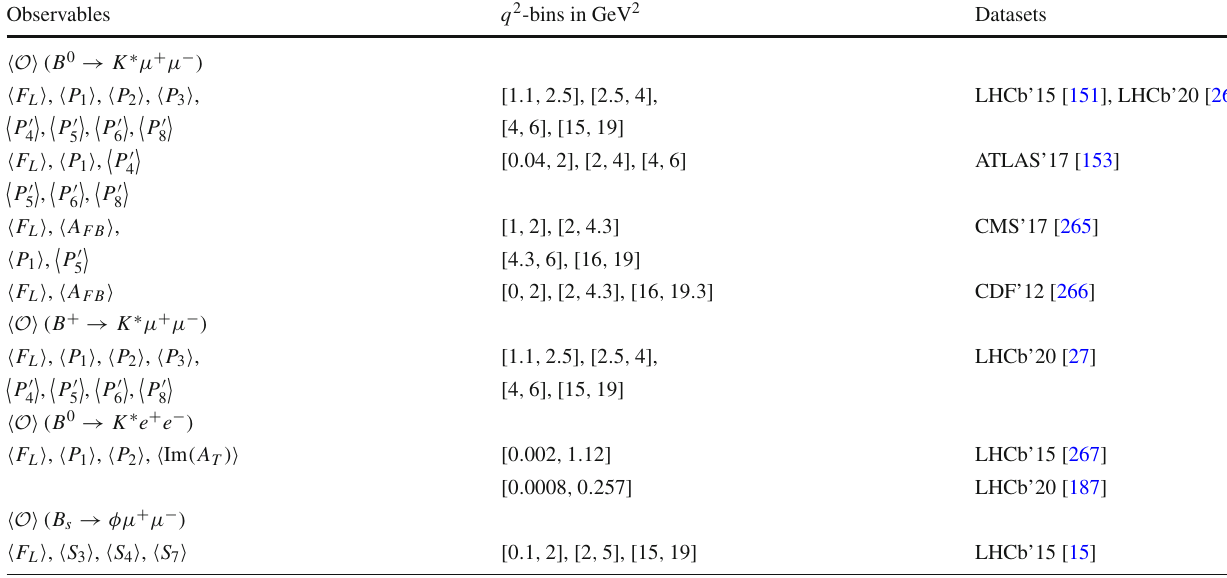
Table 6 Datasets on angular b → s μμ observables taken into account in the analysis. The 2 digits appearing after each collaborations’ name denote the years of the respective publications Observables q 2 -bins in GeV 2 Datasets